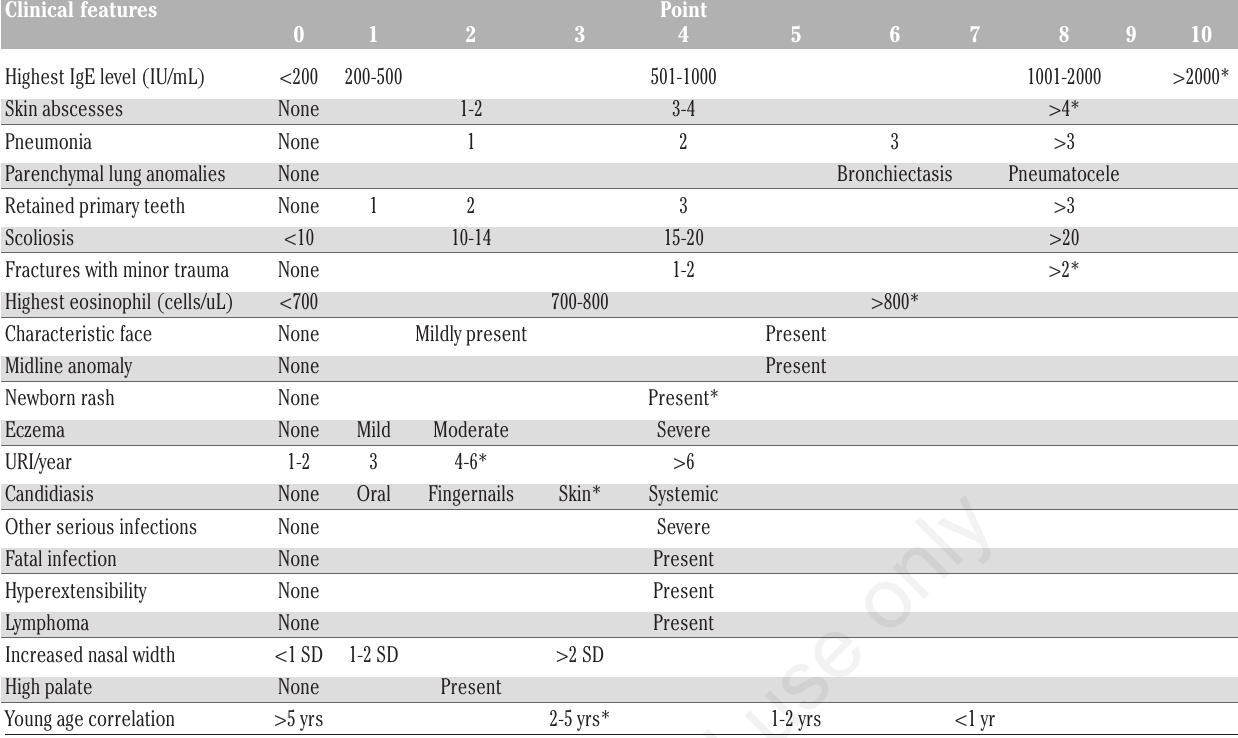
Table 1. National Institute of Health scoring system for hyperimmunoglobulin E syndrome.